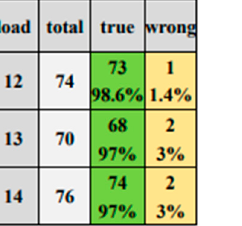
Electronics 2023 , 12 , x FOR PEER REVIEW Figure 11. Identi fi cation results of multi-state load. (Green means true, yellow means false). Figure 11. Identification results of multi-state load. (Green means true, yellow means false).